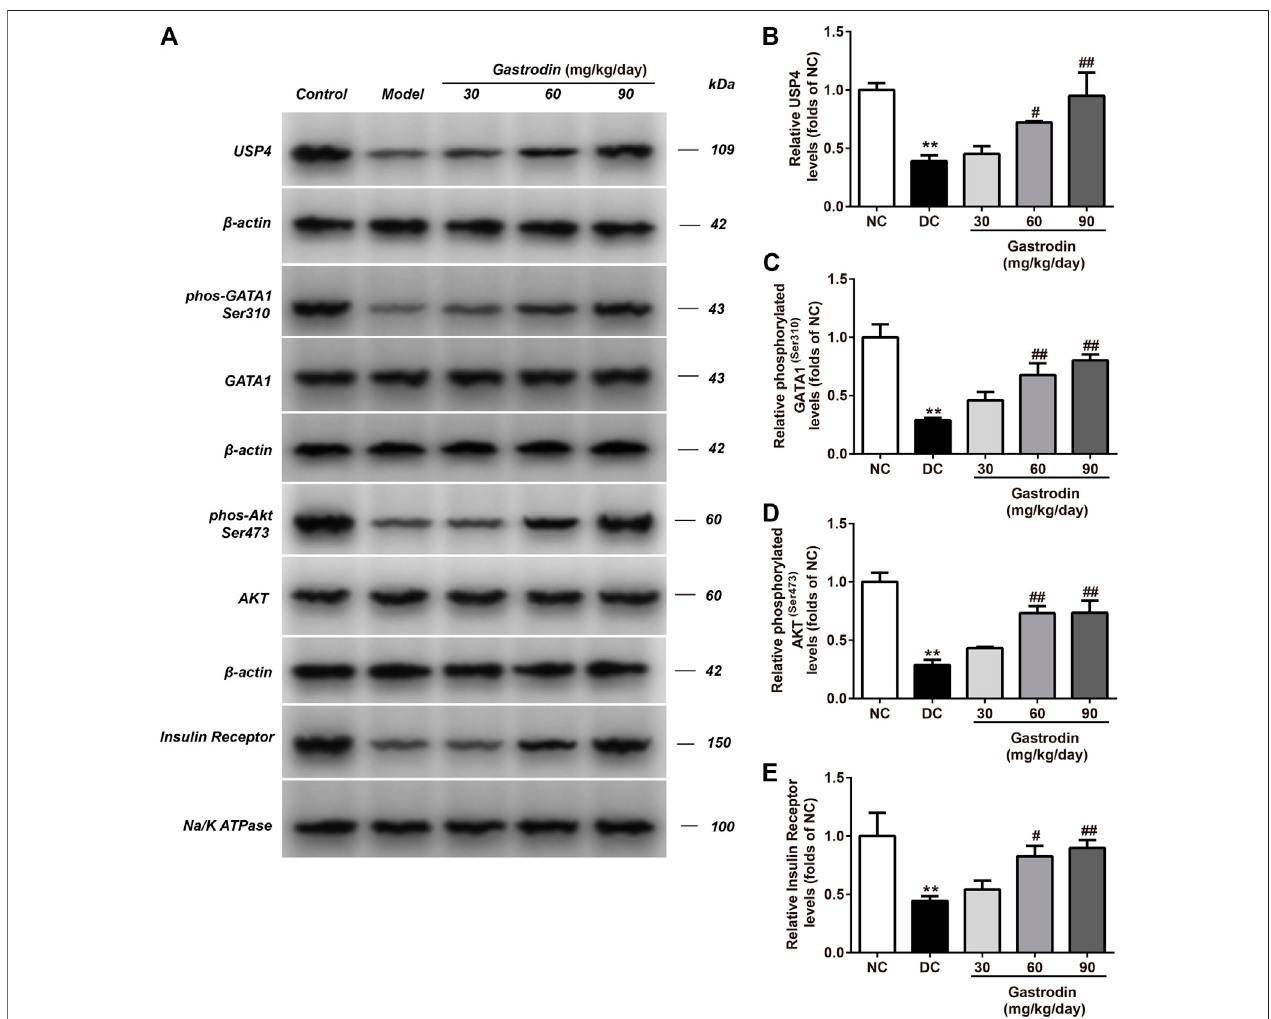
FIGURE6| ThephosphorylationlevelsofAKT,GATA1 andthelevels ofUSP4,insulinreceptorexpressionsinliverfromdifferentgroups weredetected bywestern blot assay, and representative bands were shown in (A) . The phosphorylation levels of GATA1 (C) , AKT (D) and the levels of USP4 (B) , insulin receptor (E) were normalized to NC. The results were presented as mean ± SD ( n (cid:1) 3). ** p < 0.01, vs. NC group, ## p < 0.01, vs. DC group.